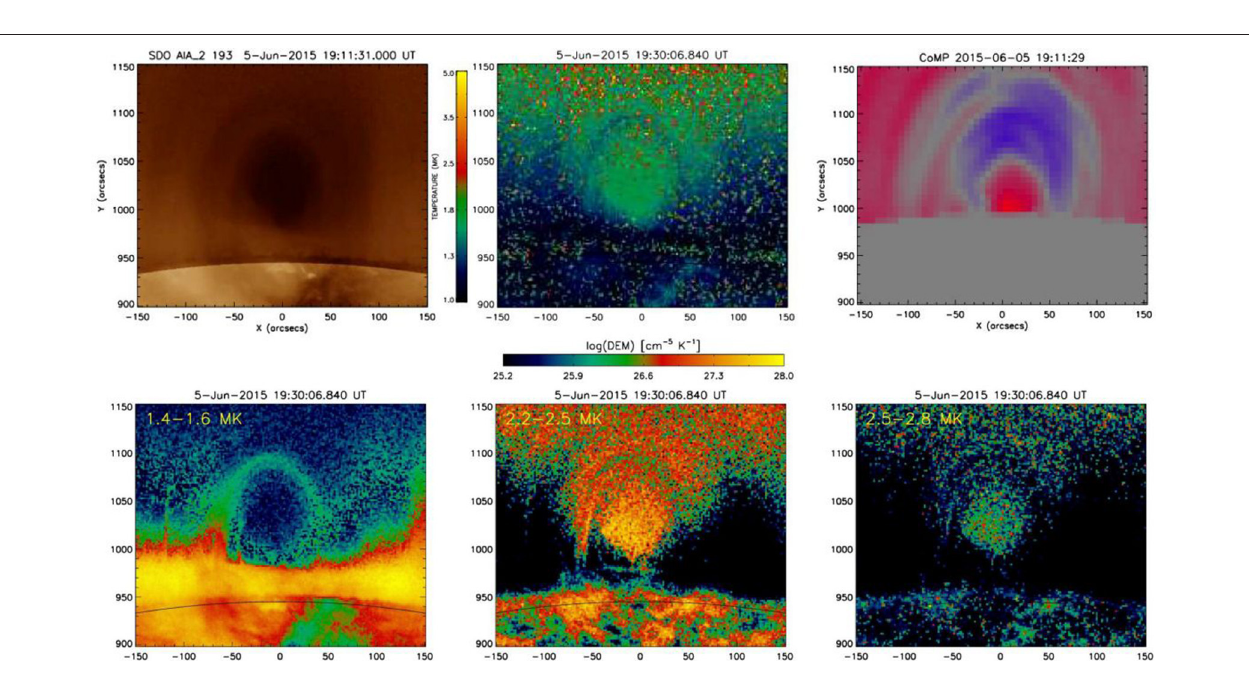
these field-aligned flows originate remain uncertain, however, and represent a challenge to magnetohydrodynamic models of prominence and cavity